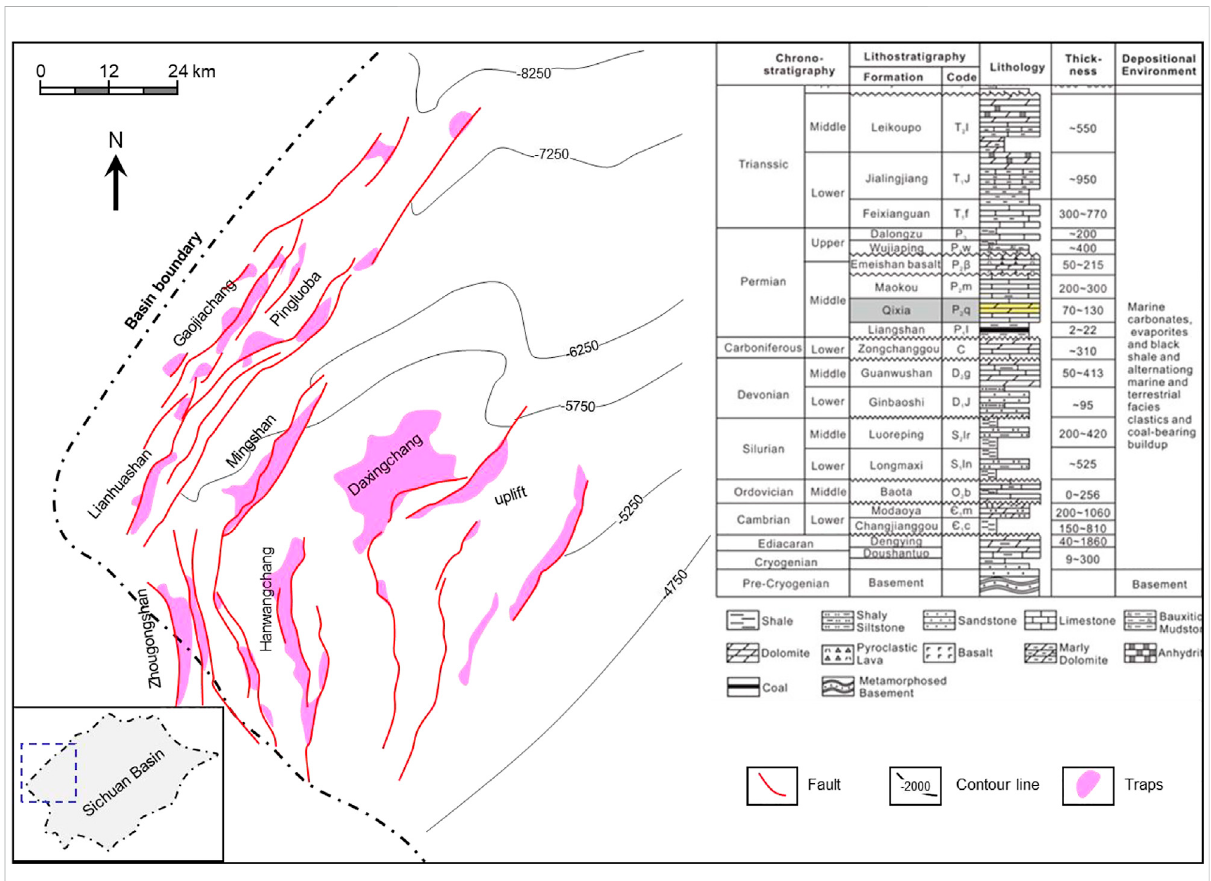
FIGURE 1 Location and generalised stratigraphy of the Sichuan Basin showing its main structures and traps on the top of the Qixia